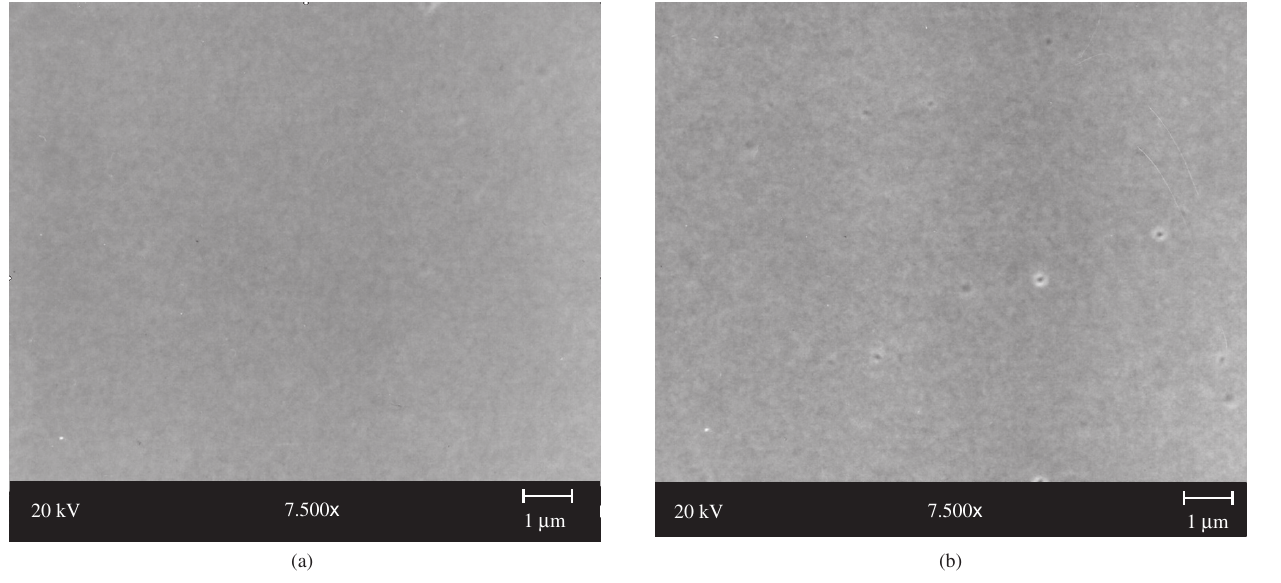
Figure 7. SEM micrograph of films: a) 70 mm/min 3 dips; and b) 50 mm/min 2